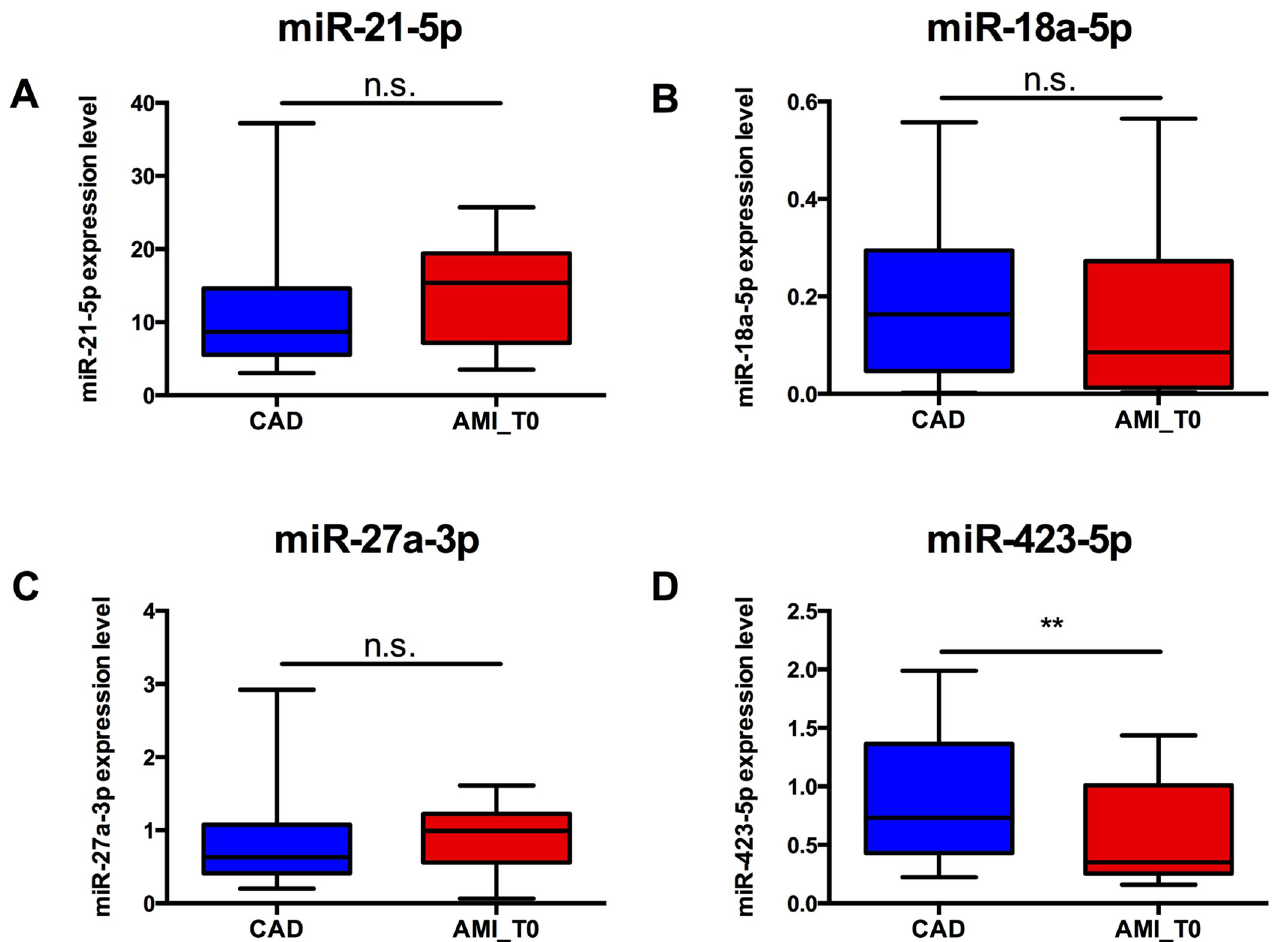
Fig 3. MiR-21-5p, miR-18a-5p, miR-27a-3p and miR-423-5p expression in AMI_T0 and CAD groups (n = 3). ( A) MiR-21-5p expression in CAD and AMI_T0 groups. Mann-Whitney U = 196, n.s. ( B) MiR-18a-5p expression in CAD and AMI_T0 groups. Mann-Whitney U = 190, n.s. ( C) MiR-27a-3p expression in CAD and AMI_T0 groups. Mann-Whitney U = 106, n.s. ( D) MiR-423-5p expression in CAD and AMI_T0 groups. Mann-Whitney U = 308, �� p � 0.005.